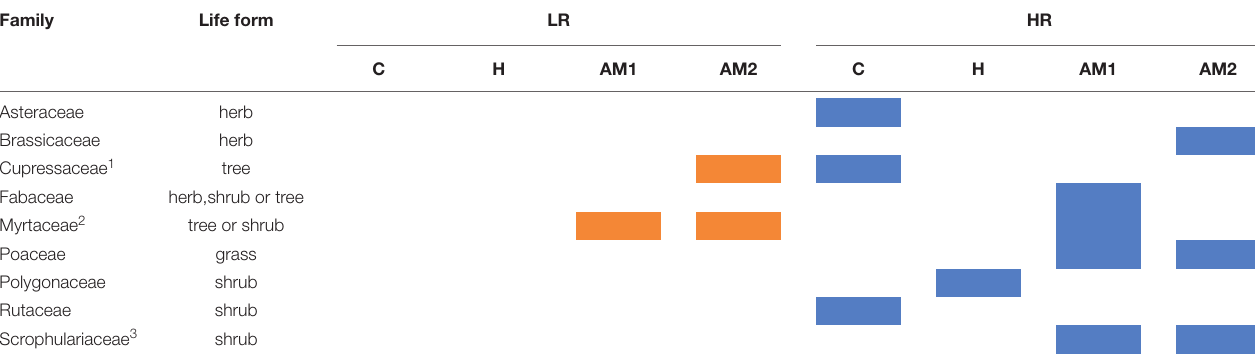
FIGURE 2 | Modelled basal plant-derived OM contributions to the diets of Copepoda Cyclopoida (C), Copepoda Harpacticoida (H), Amphipoda Scutachiltonia axfordi (AM1) and Amphipoda Yilgarniella sturtensis (AM2), during LR ( A1–4 respectively) and HR ( B1–4 respectively). Cyclopoida and Harpacticoida were included in the diet modelling of AM1 and AM2 because they are potential organic incorporation of amphipods’ diets and were previously considered in Saccò et al. (2019b). See Supplementary Table 1 for the values (mean ± SD) of the estimated contributions of the diet items. TABLE 1 | Presence-absence data of plant-derived material in stygofaunal guts extrapolated from DNA metabarcoding